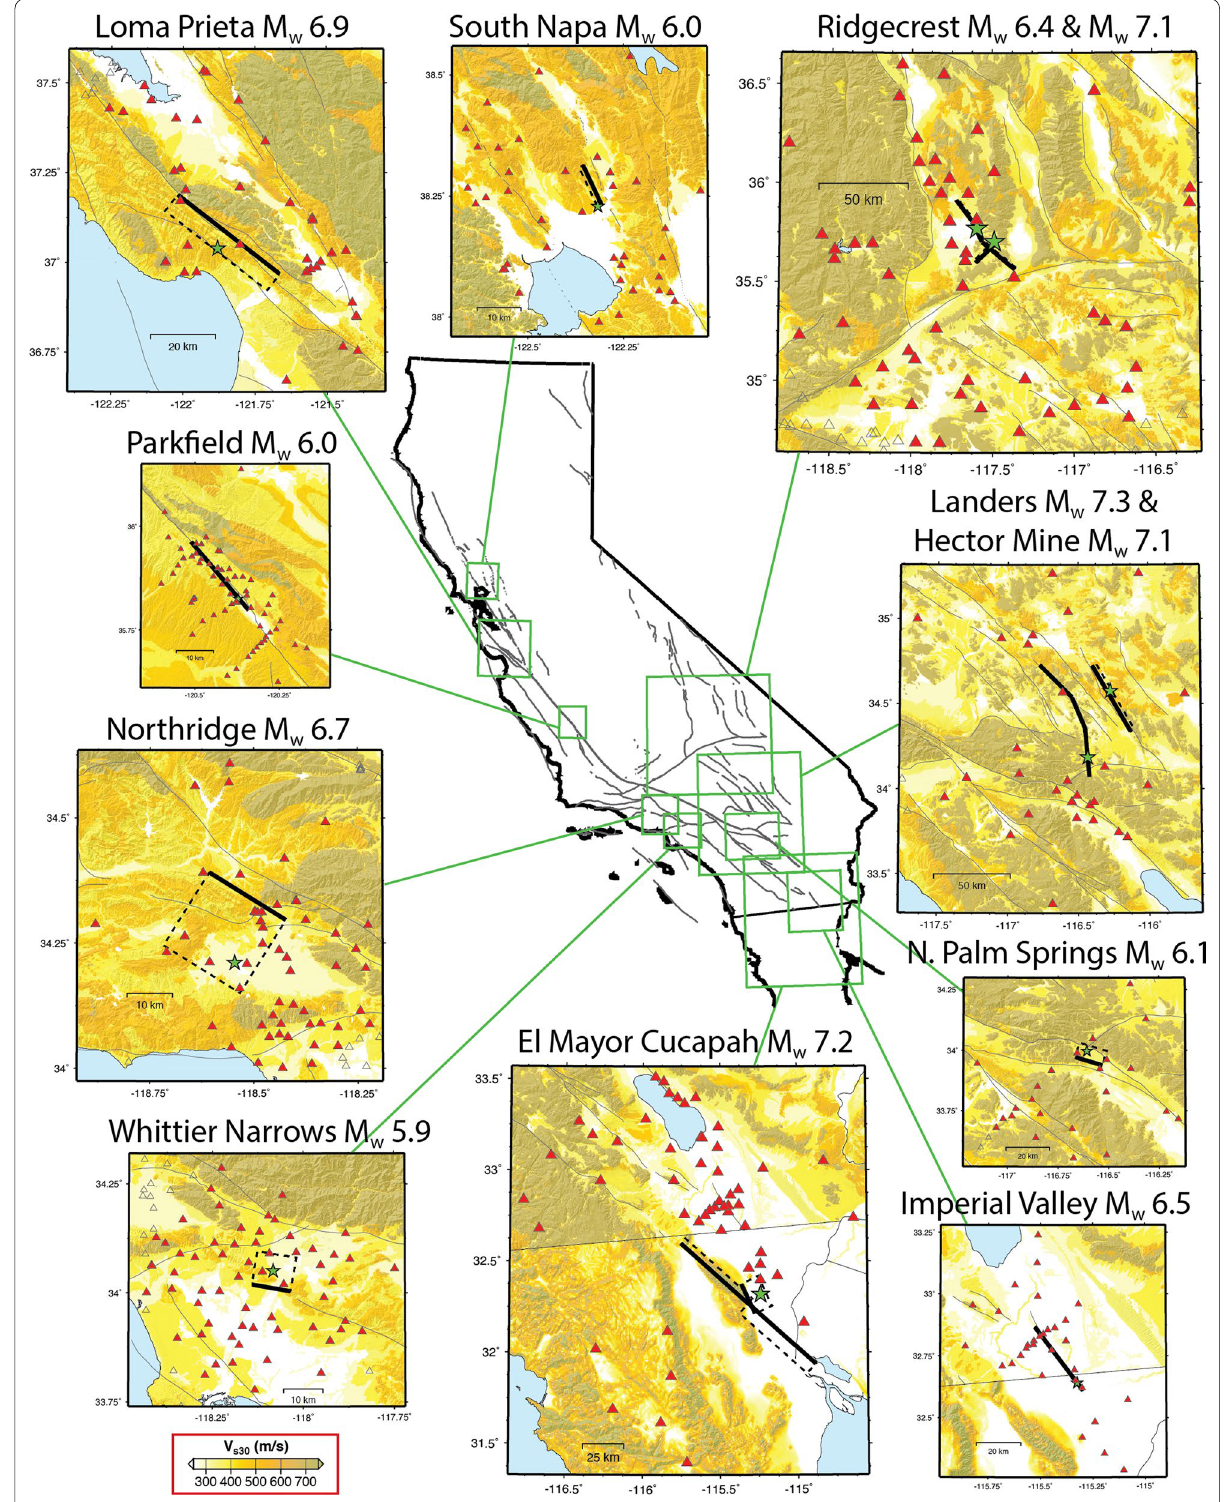
Fig. 1 Maps showing the locations of the 12 California region earthquakes analyzed in this study. Solid (top edge) and dashed black lines are the fault planes and green star is the epicenter. Red triangles are locations of strong-motion sites considered for goodness-of-fit analysis. Color shading denotes V s30 values from Wills et al.